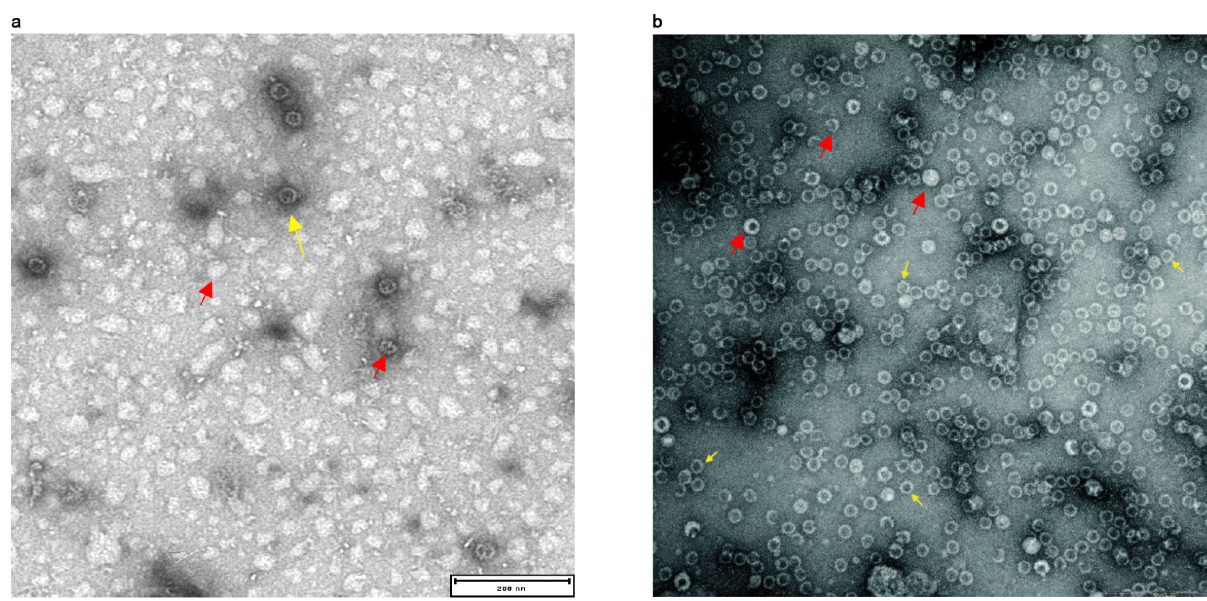
Fig 6. Negative staining transmission electron microscopy (NSTEM) analysis of HBcAg (A) and encapsulin (B) NPs exposing β Barrel in the loop. Yellow arrows indicate correctly assembled NPs. Red arrows indicate incorrectly structured NPs like aggregates, NPs partially structured or NPs with unexpected size or geometry. Scale bars inserted in the pictures correspond to 200nm